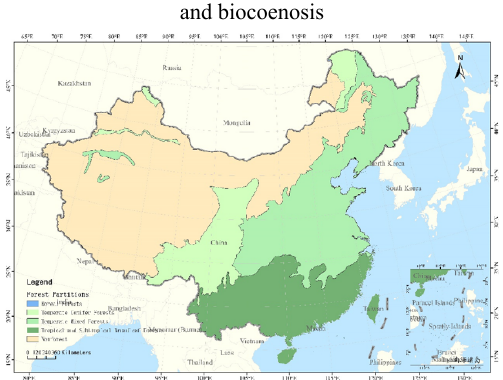
Figure 1. China forest